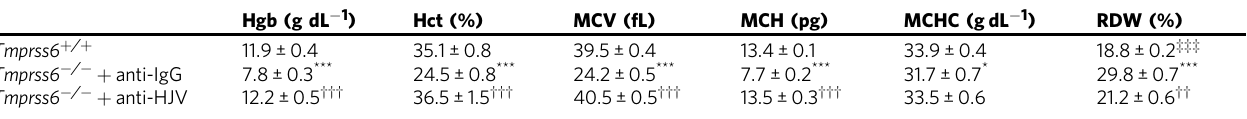
CompletebloodcountsweremeasuredfromwholebloodofHFD-fed Tmprss6 + / + ( n = 8), Tmprss6 − / − + anti-IgG( n = 5)and Tmprss6 − / − + anti-HJV( n = 8)malemiceafter18weeksofantibodytherapy upon overnight fasting Iron homeostasis dysfunctions have been associated with several metabolic disorders including obesity, steatosis, and diabetes. Here the authors demonstrate that the hepcidin repressor matriptase-2 regulates adiposity and its de fi ciency protects mice against obesity and promotes lipolysis Data are presented as mean±SEM Hgb hemoglobin, Hct hematocrit, MCV mean corpuscular volume, MCH mean corpuscular hemoglobin, MCHC mean corpuscular hemoglobin concentration, RDW red cell distribution width * P <0.05; *** P <0.001, two-tailed Student ’ s t test and Mann – Whitney test Tmprss6 − / − + anti-IgG versus Tmprss6 + / + mice